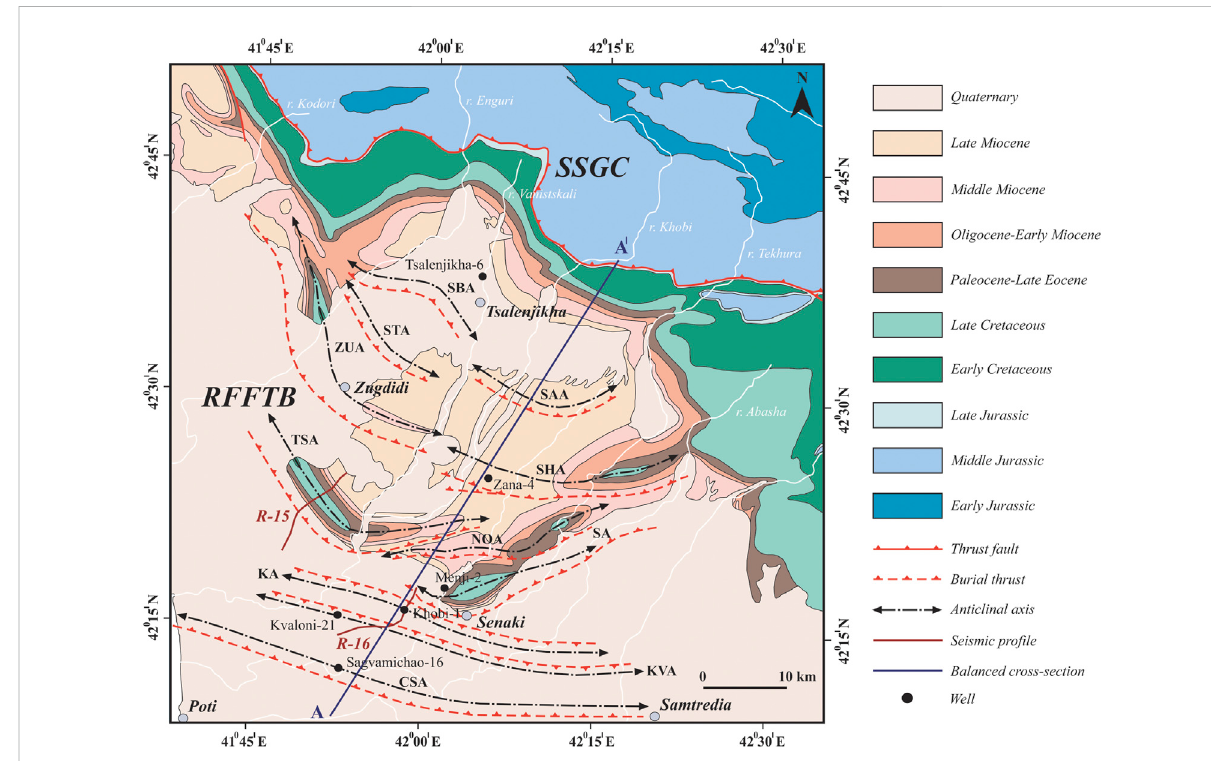
FIGURE 2 GeologicalmapofRFFTBandsurroundingarea(modi fi edfromJanelidzeandKandelaki,1956;Vakhania,2008a,Vakhania,2008b;Adamiaetal., 2020). Abbreviations: RFFTB, Rioni foreland fold-and-thrust belt; SSGC, Southern Slope of Greater Caucasus; CSA, Chaladidi-Sagvamischao anticline; KVA, Kvaloni anticline; KA, Khobi anticline; SA-Senaki anticline; NOA, Nokhalakhevi anticline; TSA, Tsaishi anticline; SHA, Sashurgaio anticline; ZUA, Zugdidi anticline; STA, Satanjo anticline; SBA, Saberios anticline; SAA, Sarakoni